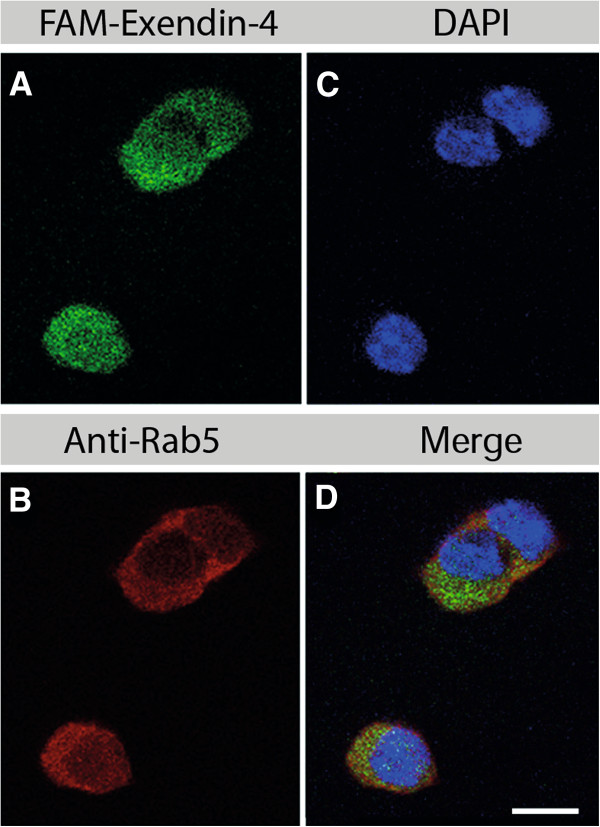
Subcellular localization of fluorescein-Trp25-exendin-4 in cultivated tumor β-cells of Rip1Tag2 mice 2 h after injection. Tumor beta-cells were incubated with fluorescein-Trp25-exendin-4 (A, green), anti-Rab5a (B, red, an anti-early endosome antibody), and nuclear DAPI stain (C, blue). Fluorescein-Trp25-exendin-4 was internalized into the cytoplasm and to a much lower degree into the nuclei of the tumor beta-cells. However, no strong co-localization was observed (D, merged picture). Scale bar, 10 μm.